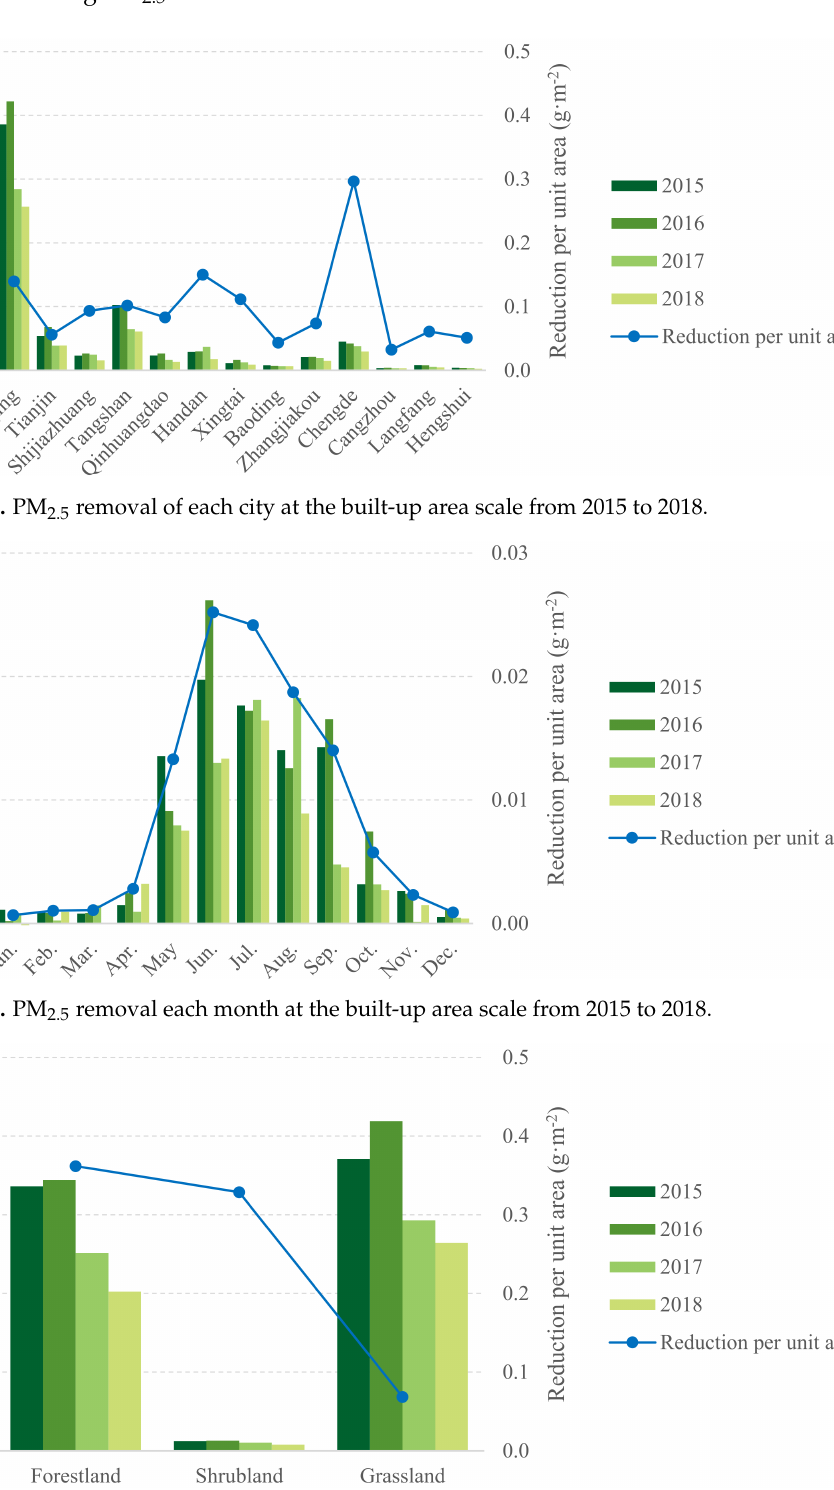
Figure 18. PM 2.5 removal of each green space type at the built-up area scale from 2015 to